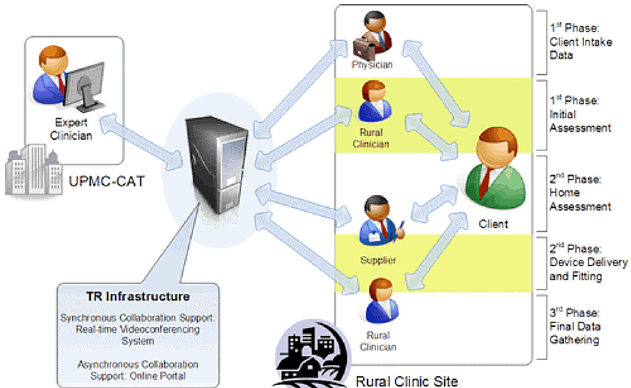
Figure 3. Conceptual Interaction Flow of the Remote Wheelchair Prescription Service Team